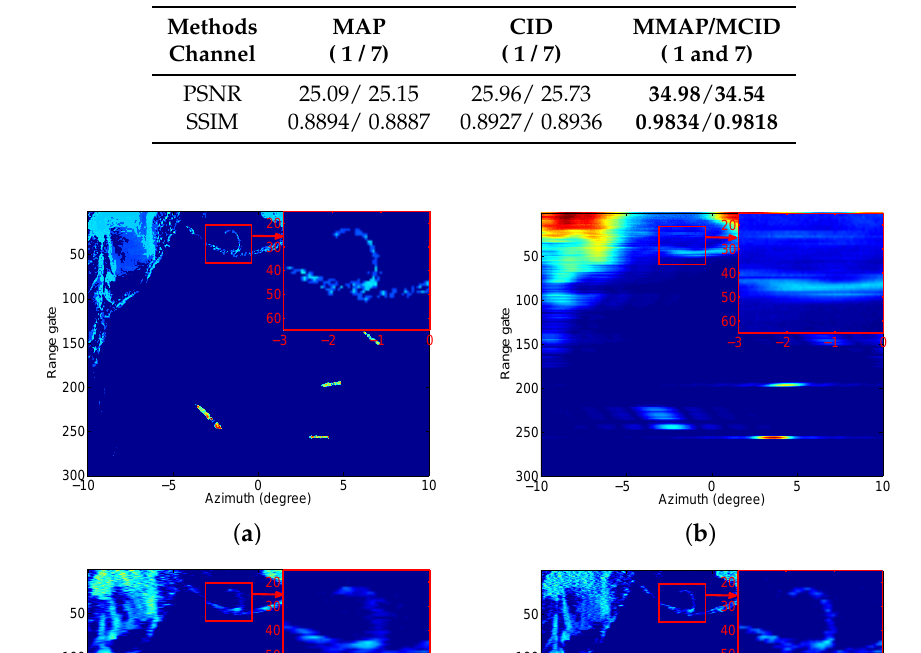
Table 3. The PSNR and SSIM of reconstruction results by different methods